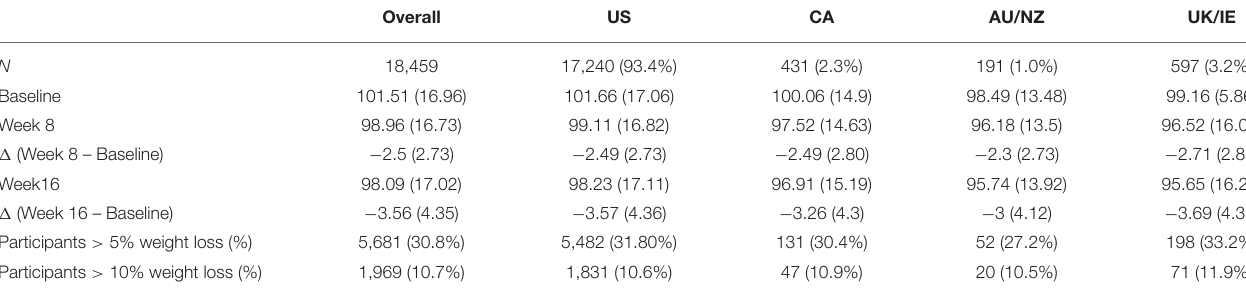
TABLE 2 | Mean weight (kg) and weight change (kg) by